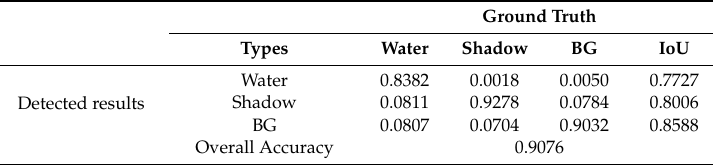
Table 1. Mean Classification results of the two experiments.